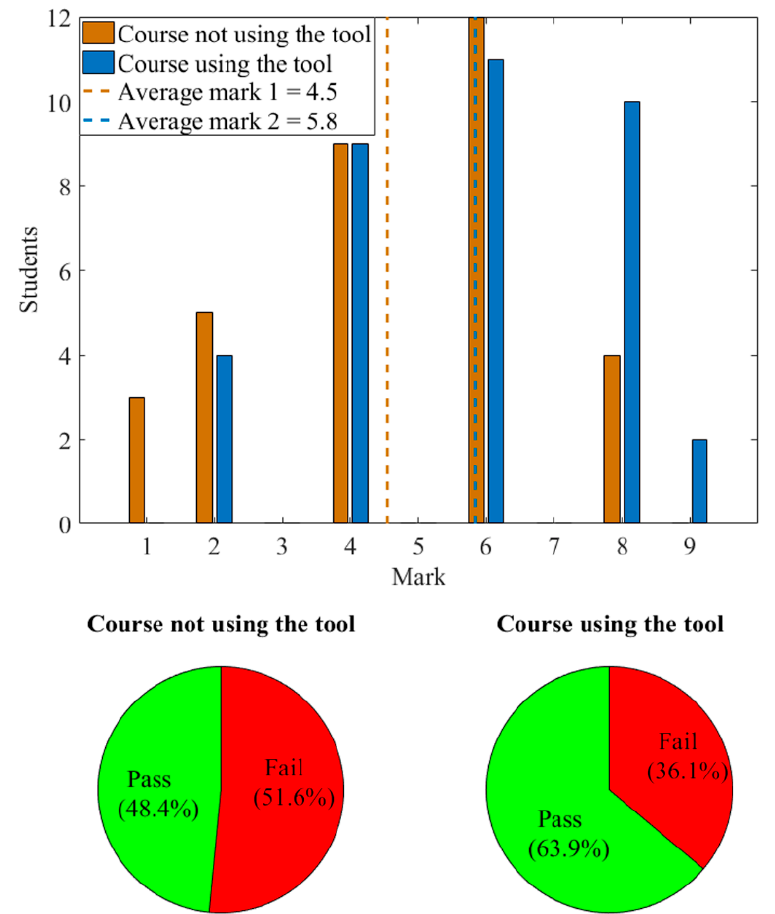
Figure 14. Comparison of exam scores between groups ‘using the tool’ and ‘not using the tool’.